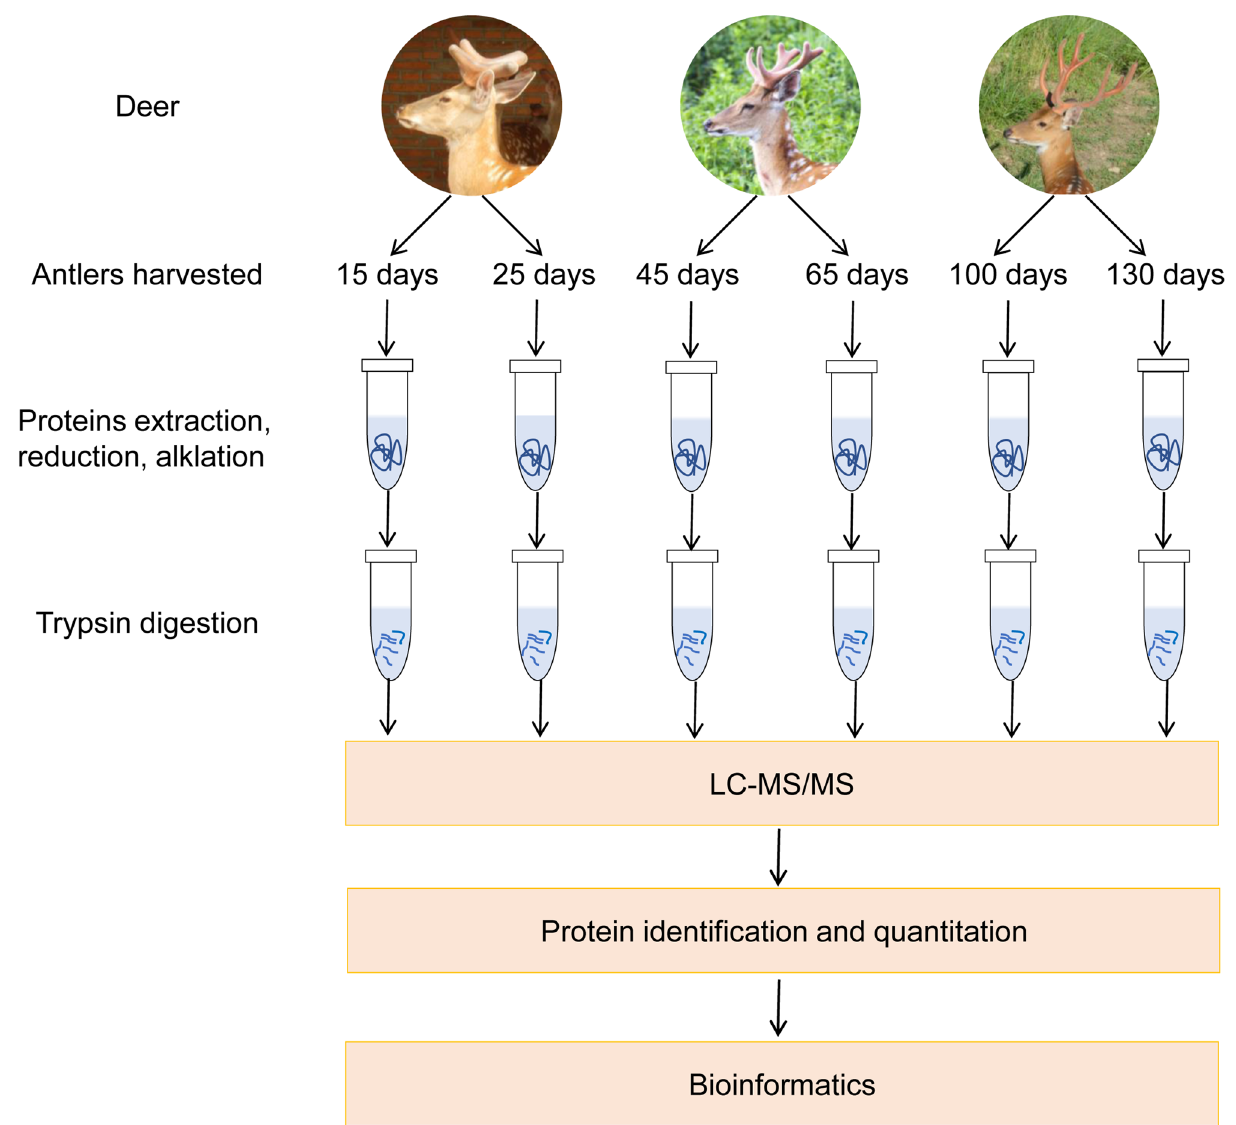
Figure 1. Flowchart of proteomic analysis of sika deer antlers at different development stages. 3 4-year-old male sika deer were selected. The two antlers from first deer were harvested at 15 and 25 days respectively, the two antlers of the second deer were harvested at 45 and 65 days respectively, and the two antlers of the last deer were harvested at 100 and 130 days respectively. LC–MS/MS was performed three times per phoadenosine 5 ′ -phosphosulfate synthase 1, bifunctional 3 ′ -phosphoadenosine 5 ′ -phosphosulfate synthase 2 (Table S1). The biological process enrichment results showed that these proteins were mainly involved in translational initiation, mRNA processing, Wnt signaling pathway, protein transport, osteoblast differentiation, endochondral ossification etc. Moreover, the cell component results showed that they were mainly localized in membrane, cytosol, nucleoplasm, endoplasmic reticulum etc. (Fig. 5A). 144 proteins were gone in the last time point of the ossification phase. Among that, aggrecan core protein is a major component of extracellular matrix of cartilagenous tissues and Collagen alpha-1(XI) chain may play an important role in fibrillogenesis by control- ling lateral growth of collagen II fibrils. The enrichment results showed that these proteins were enriched into the biological process of translational initiation, chaperone-mediated protein folding and extracellular matrix organization (Fig. 5B). Although 100 days and 130 days were classified into ossification phase there were still significant differences. There were 33 proteins expressed specifically in 100 days. Among that, the LFQ inten- prostaglandin A2 (PGA2) and prostaglandin J2 (PGJ2). Tartrate-resistant acid phosphatase type 5, a classical markers of bone resorption and osteoclast differentiation, is also concluded in the list of 100-day special protein. The enrichment results showed the proteins were mainly involved in negative regulation of superoxide anion generation and high-density lipoprotein particle remodeling and located in extracellular exosome (Fig. 5C). 53